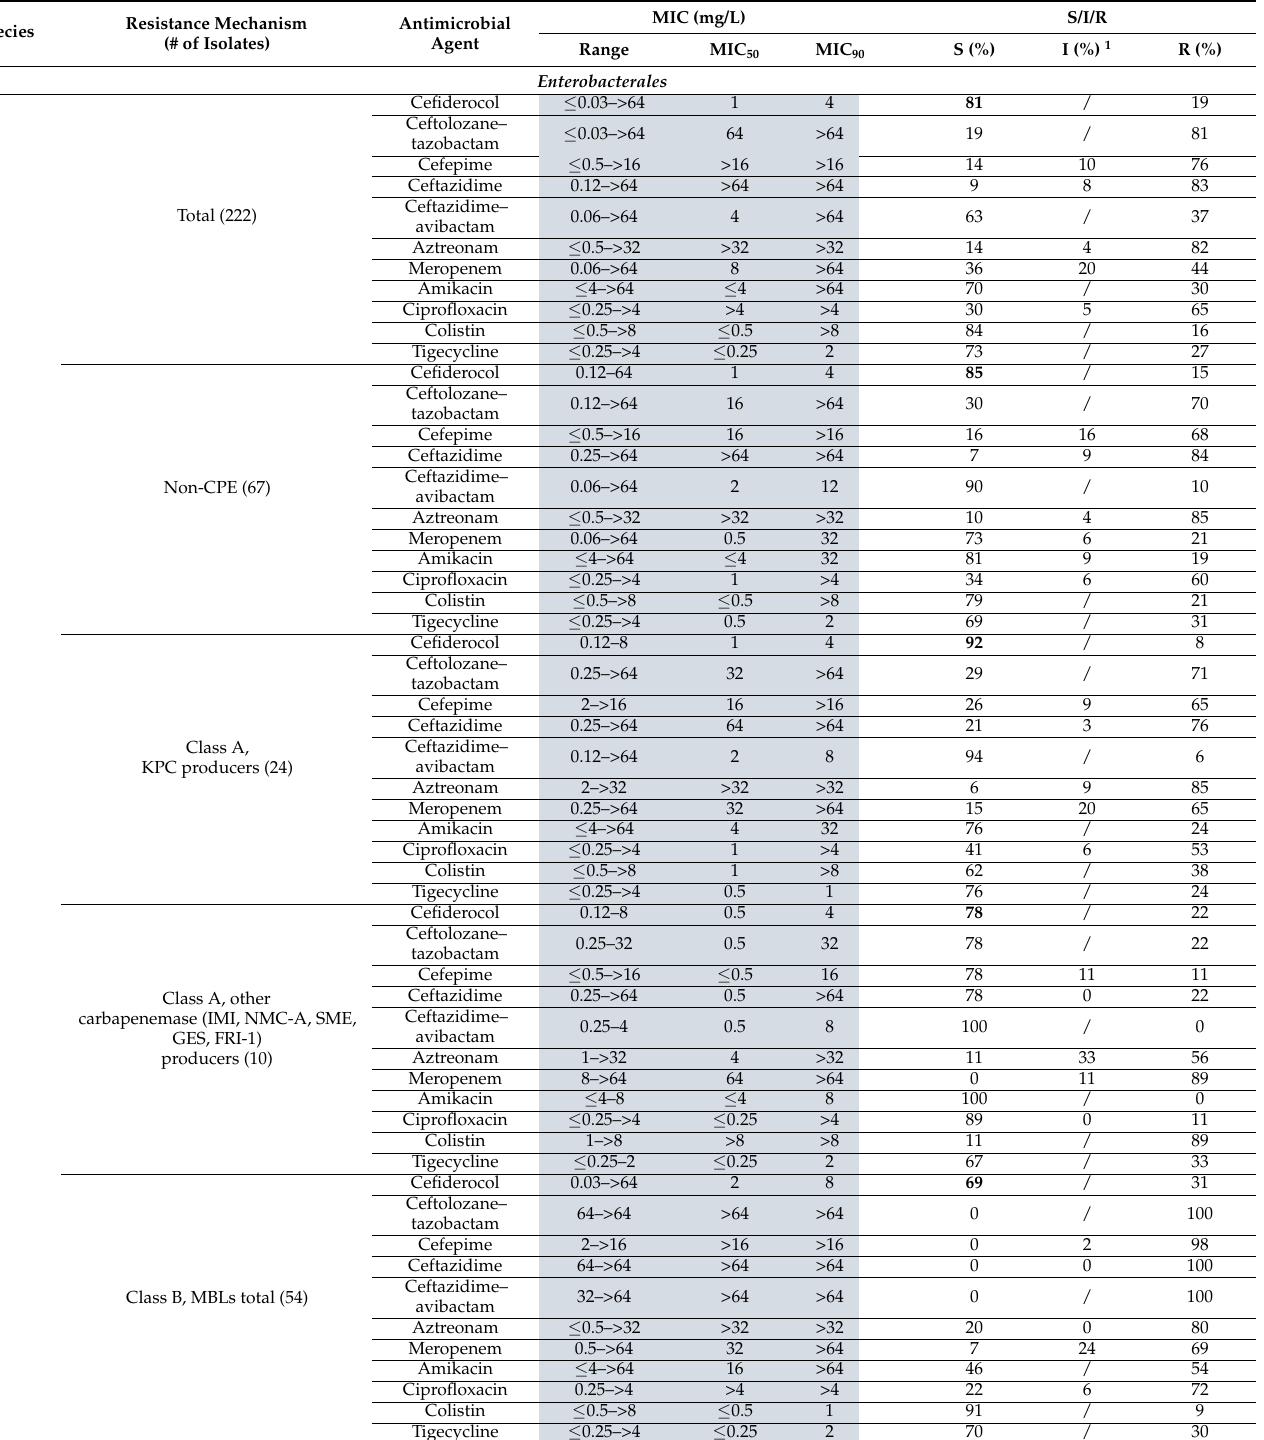
Table 3. In vitro activity of cefiderocol and comparators against Enterobacterales, P. aeruginosa and A. baumannii with reduced susceptibility to carbapenems received at the French and Belgium NRC for antibiotic resistance in GN according to EUCAST